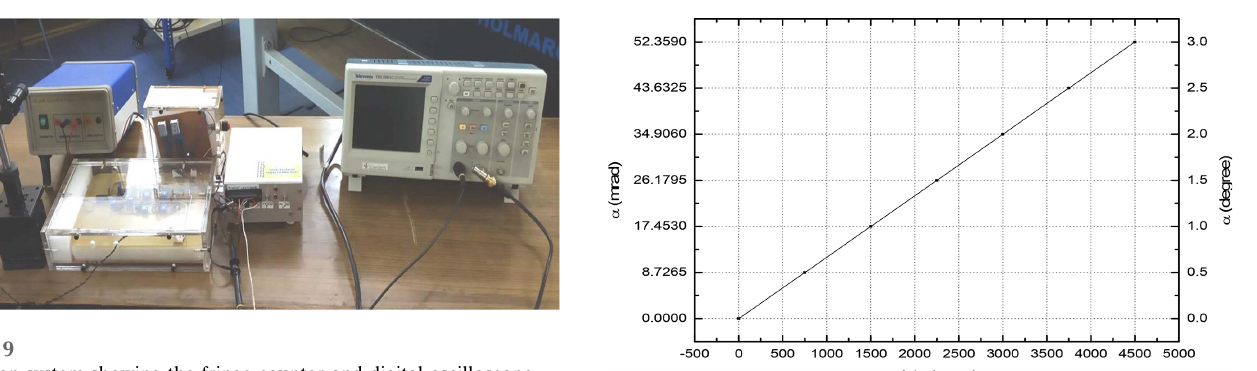
Figure 12 Effect of the angular tilt at the clamp end on the field along the horizontal